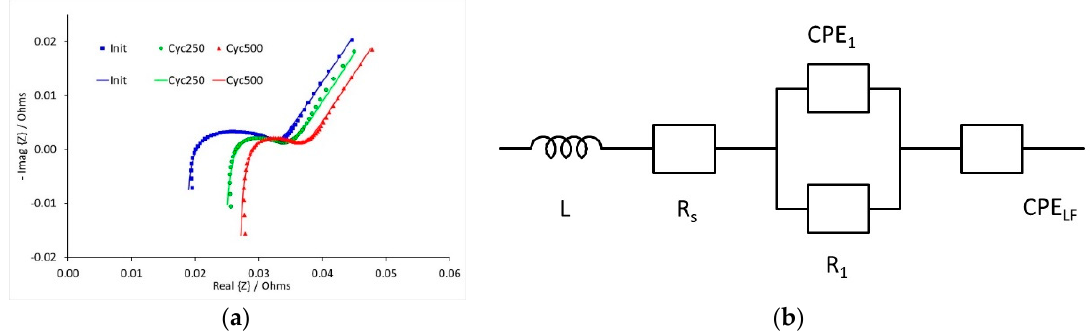
Figure 9. Typical Electrochemical Impedance Spectroscopy (EIS) Results. ( a ) impedance spectra at 10% SOC and ( b ) equivalent circuit.